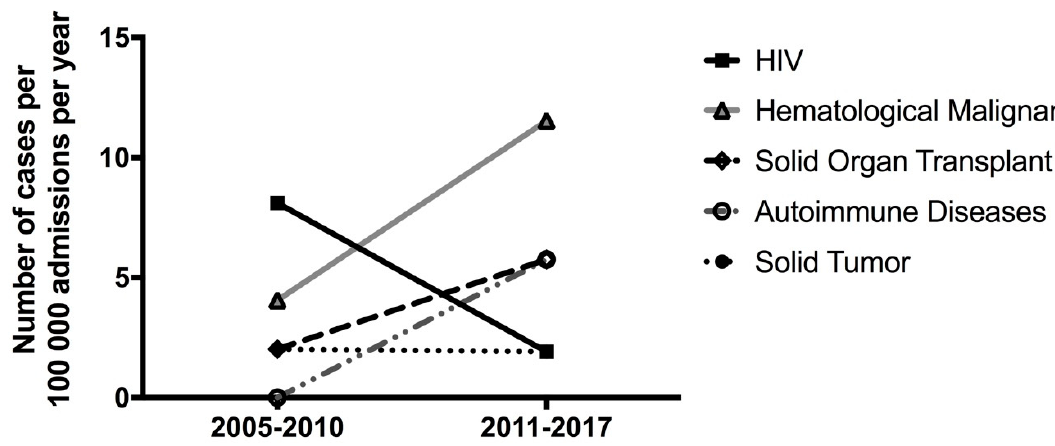
Figure 2. Number of cryptococcal infection cases per 100,000 admissions per year for each underlying comorbidity organized by the decade in which the case was reported.